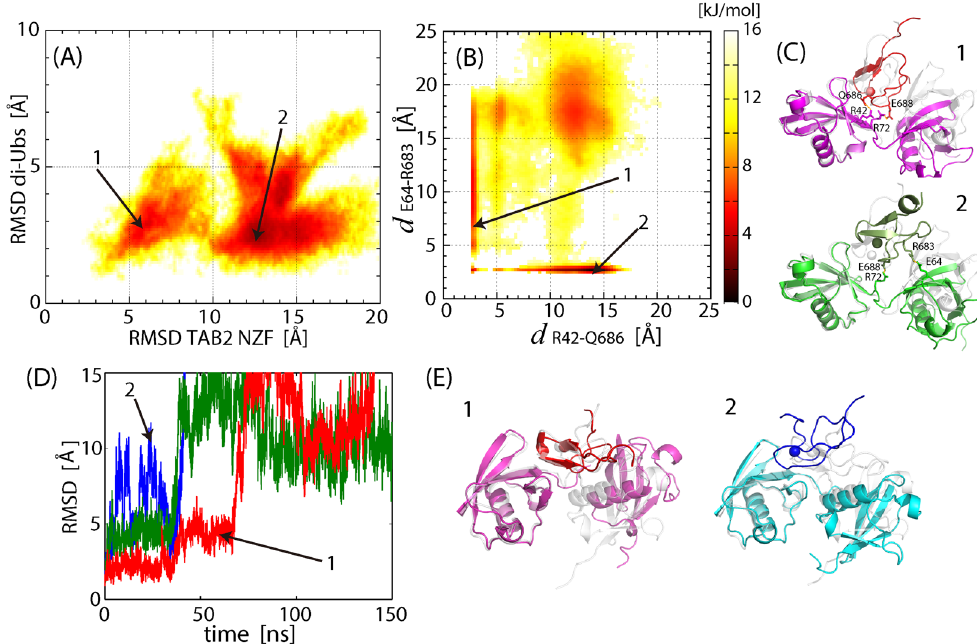
Figure 6. MD simulations of linear di-Ub/TAB2 NZF and K33 di-Ub/TAB2 NZF. ( A ) FES of linear di-Ub/ TAB2 NZF obtained in the MSES simulation, plotted on a two-dimensional space, C α RMSD values of TAB2 NZF and di-Ub from the initial homology model, after superimposing C α atoms of di-Ub (1–70). ( B ) The same as ( A ), but plotted on the two distances, d R42-Q686 and d E140-R683 . ( C ) Two representative structures whose positions in the FES are indicated in ( A , B ). TAB2 NZF changes the position by rotation while maintaining the salt bridge, R72-E688. ( D ) Time courses of C α RMSD value of K33 di-Ub/TAB2 NZF from the initial homology model, after superimposing C α atoms of di-Ub (1–70), obtained in the three 150-ns MD simulations (colored in red, blue, and green). The blue curve overshoots the range of the figure. ( E ) Two representative structures indicated in ( D